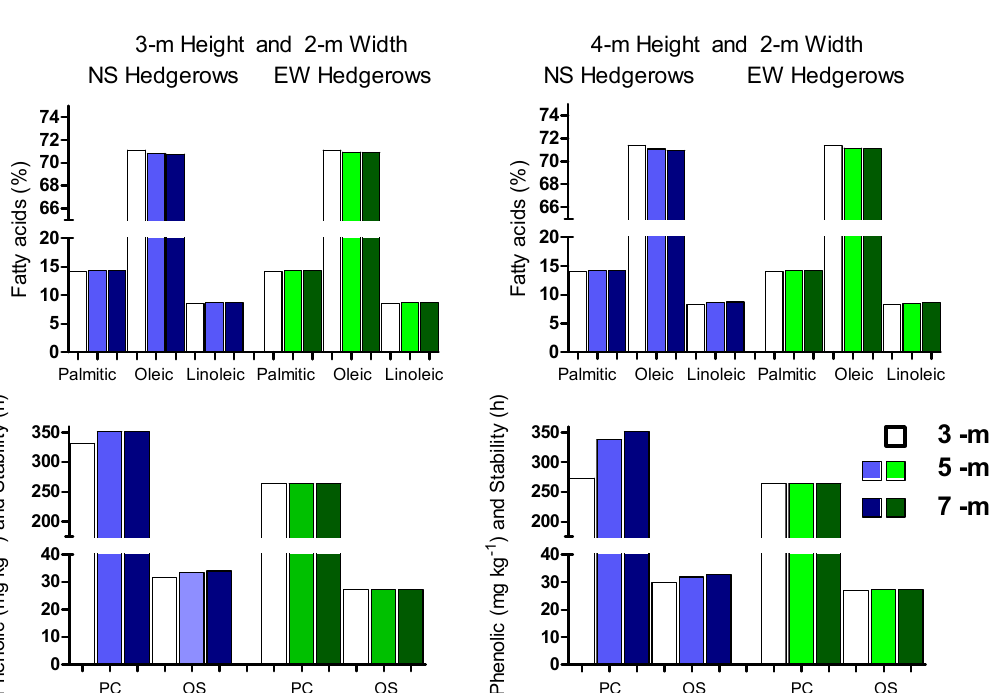
Figure 5. Simulated oil quality; concentrations of palmitic, oleic and linoleic acids; phenolic compounds (PC); and oxidative stability (OS) of 2-m wide hedgerows of 3- and 4-m height, respectively, each at three row spacings (3, 5 and 7 m) and two row orientations (NS and EW) in response to internal hedgerow irradiance during the fruit-filling period (DOY 150–310) at 39.9 ◦ N (see Figure 3).